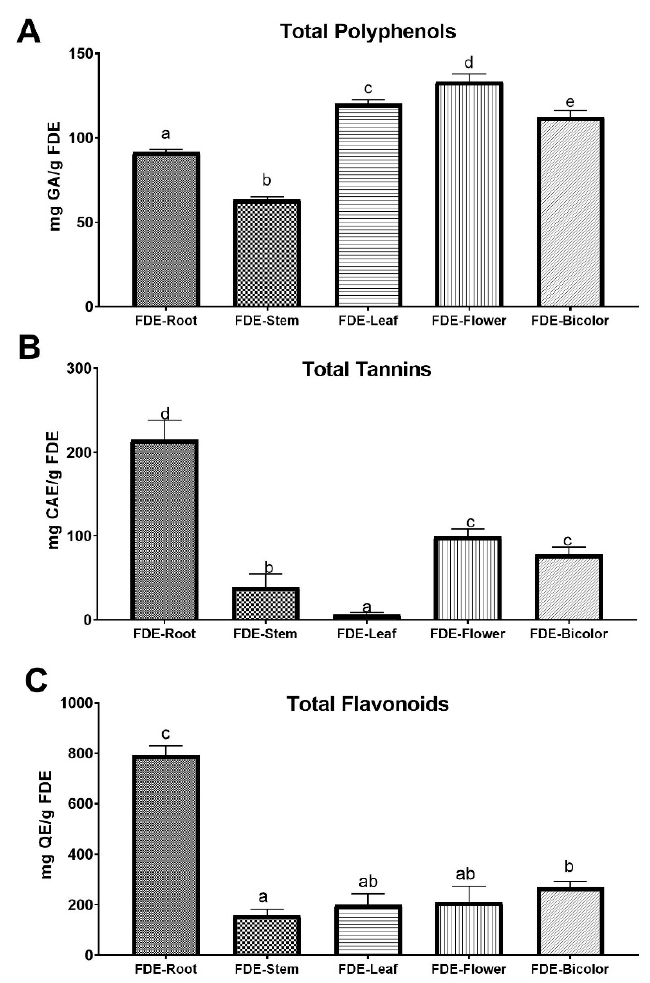
Figure 1. Quantification of secondary metabolites from P. peltatum FDE. ( A ) total polyphenols, ( B ) tannins, and ( C ) flavonoids in hydroalcoholic extract of P. peltatum . The histogram shows the values of the means ± S.D. of three independent experiments and the Tukey L.S.D. test showing homogeneous groups with a p < 0.005. Different lowercase letters (a, b, c, d and e) on the top of columns represent significant difference ( p < 0.05).